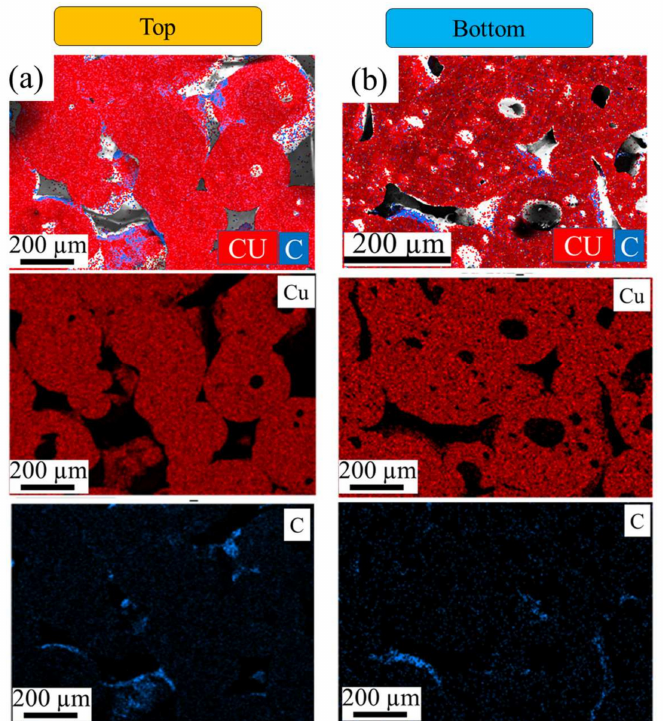
Figure 7. Energy-dispersive spectroscopy (EDS) mapping of the as-fabricated Cu-CNTs from ( a ) top and ( b ) bottom surface showing CNTs distribution on surface of the Cu powders.